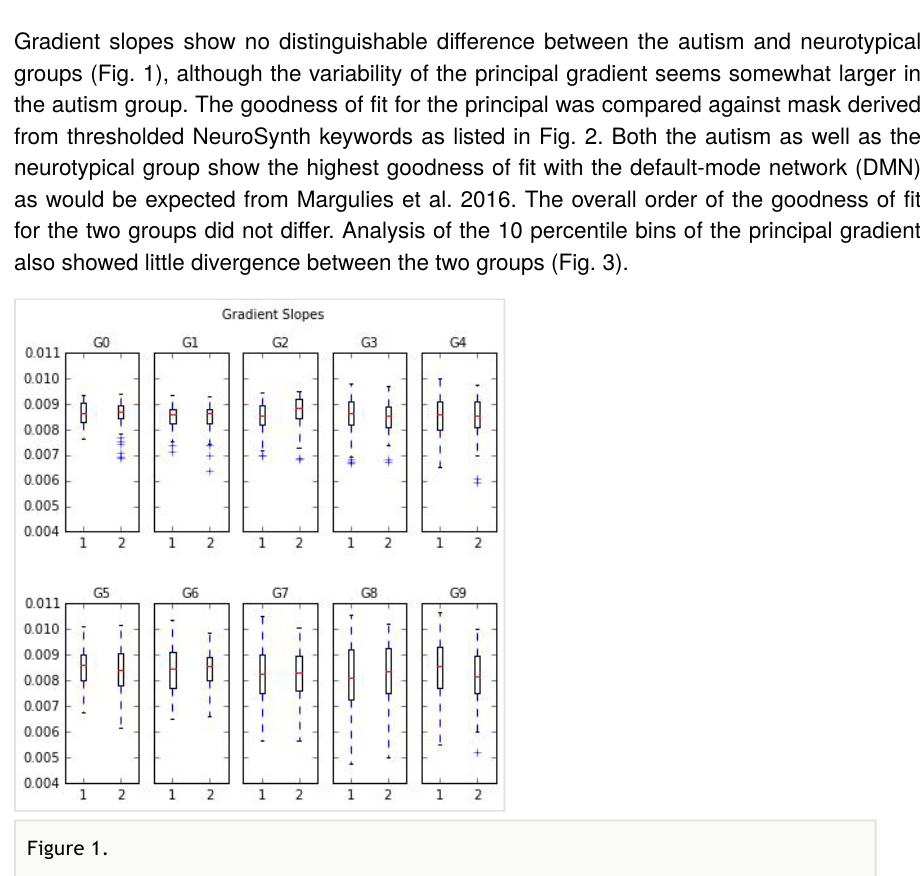
Linear fi t of gradient slopes for the top 10 gradients for each group (1 == neurotypical individuals; 2 == individuals with